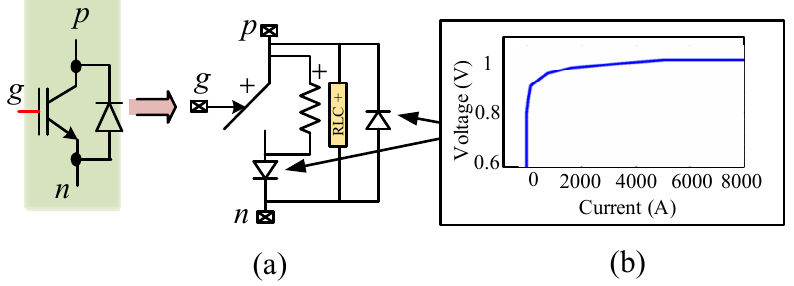
Figure 6. ( a ) Illustration of a nonlinear IGBT valve. ( b ) Diode V-I characteristics.